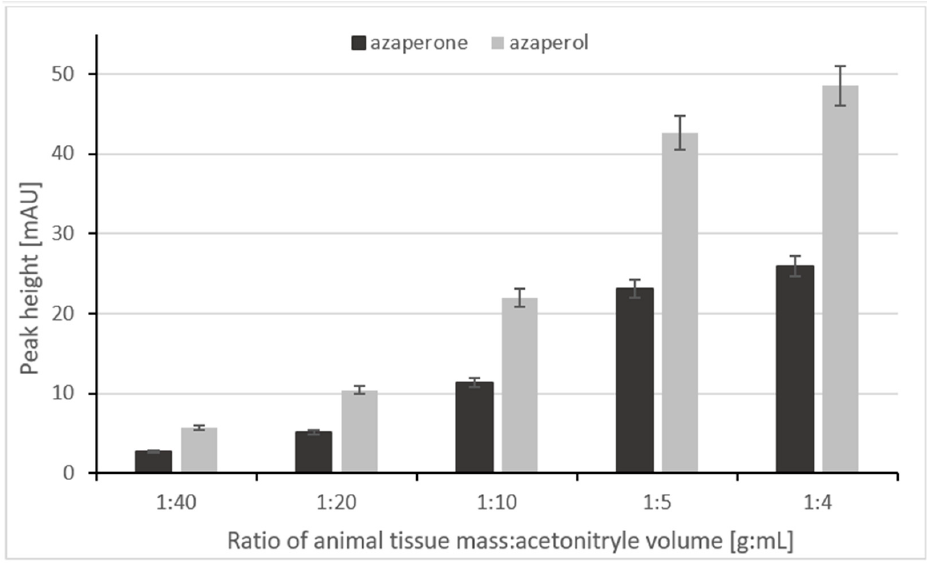
Figure 2. The relationship between peak height and the ratio of animal tissue mass to acetonitrile volume.